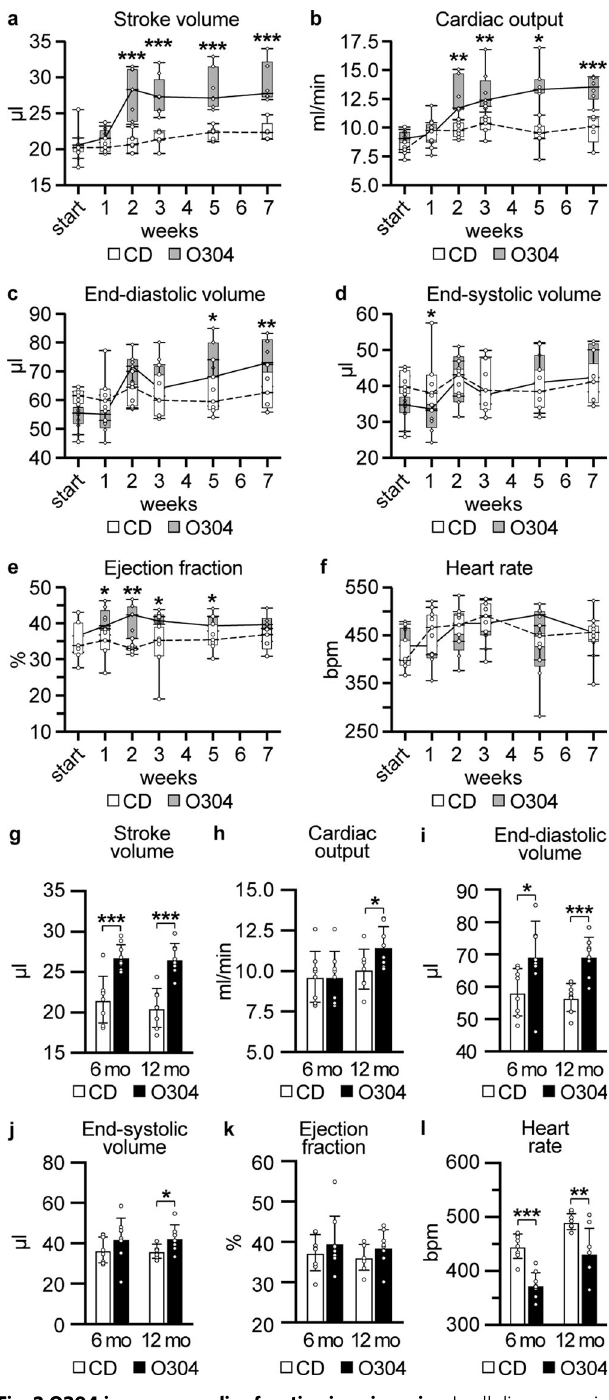
Fig. 2 O304 improves cardiac function in aging mice. In all diagrams mice were fed CD or O304-0.5 from 6 months of age. a – f Stroke volume ( a ), cardiac output ( b ), end-diastolic volume ( c ), end-systolic volume ( d ), ejection fraction ( e ), and heart rate ( f ), in mice fed CD ( n = 7) or O304-0.5 ( n = 6) for 7 weeks. g – l Stroke volume ( g ), cardiac output ( h ), end-diastolic volume ( i ), end-systolic volume ( j ), ejection fraction ( k ), and heart rate ( l ), in mice fed CD ( n = 8) or O304-0.5 ( n = 8) for 6 and 12 months (mo). Data are presented as mean ± s.d. Student ’ s t -test between CD and O304- 0.5 at respective time point. * P ≤ 0.05, ** P ≤ 0.01, and *** P ≤